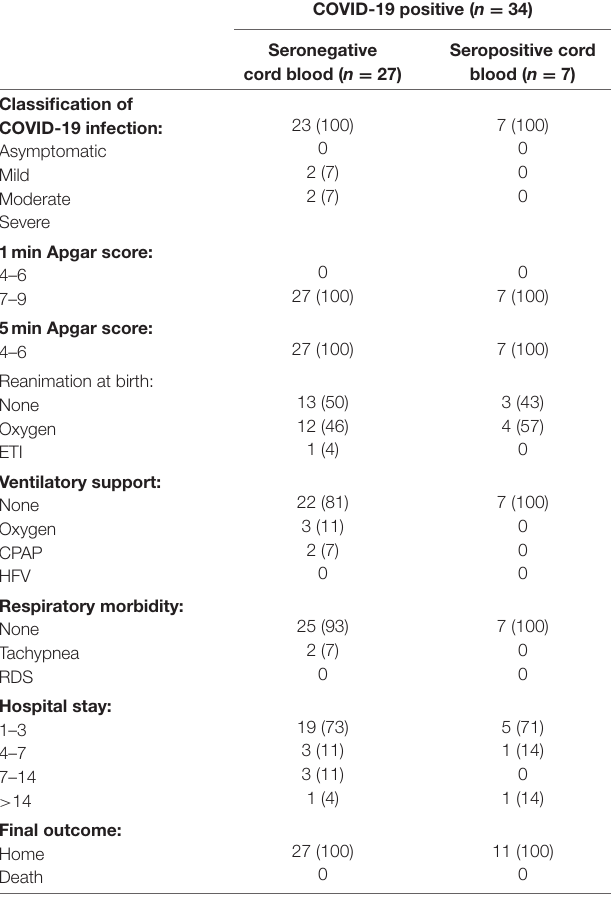
TABLE 1 | Neonatal outcomes relative to seropositivity in cord blood samples in the COVID-19 positive